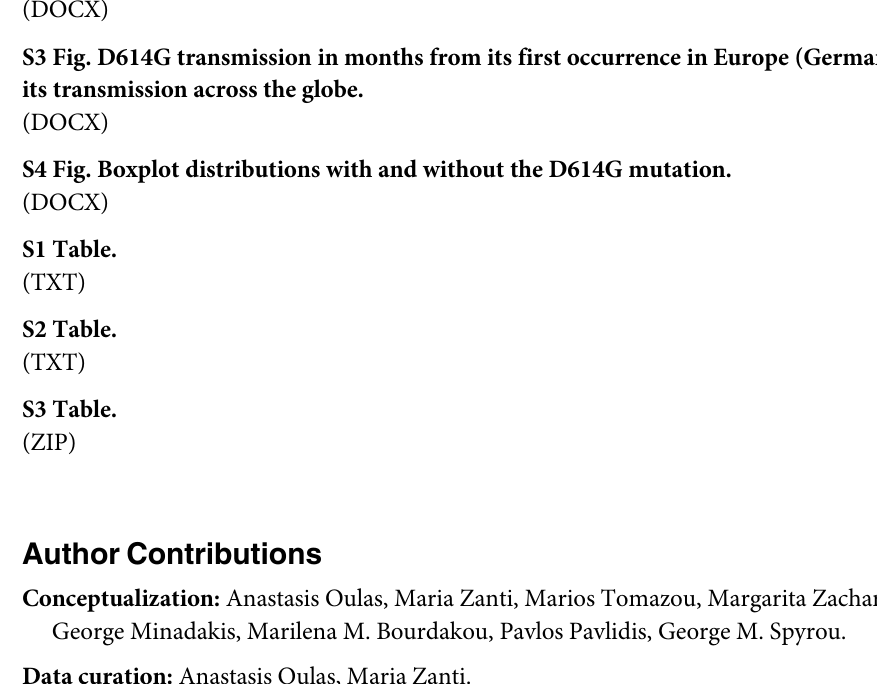
S2 Fig. Phylogenetic trees using 16,535 trimmed full genome SARS- CoV-2 strains from GISAID.